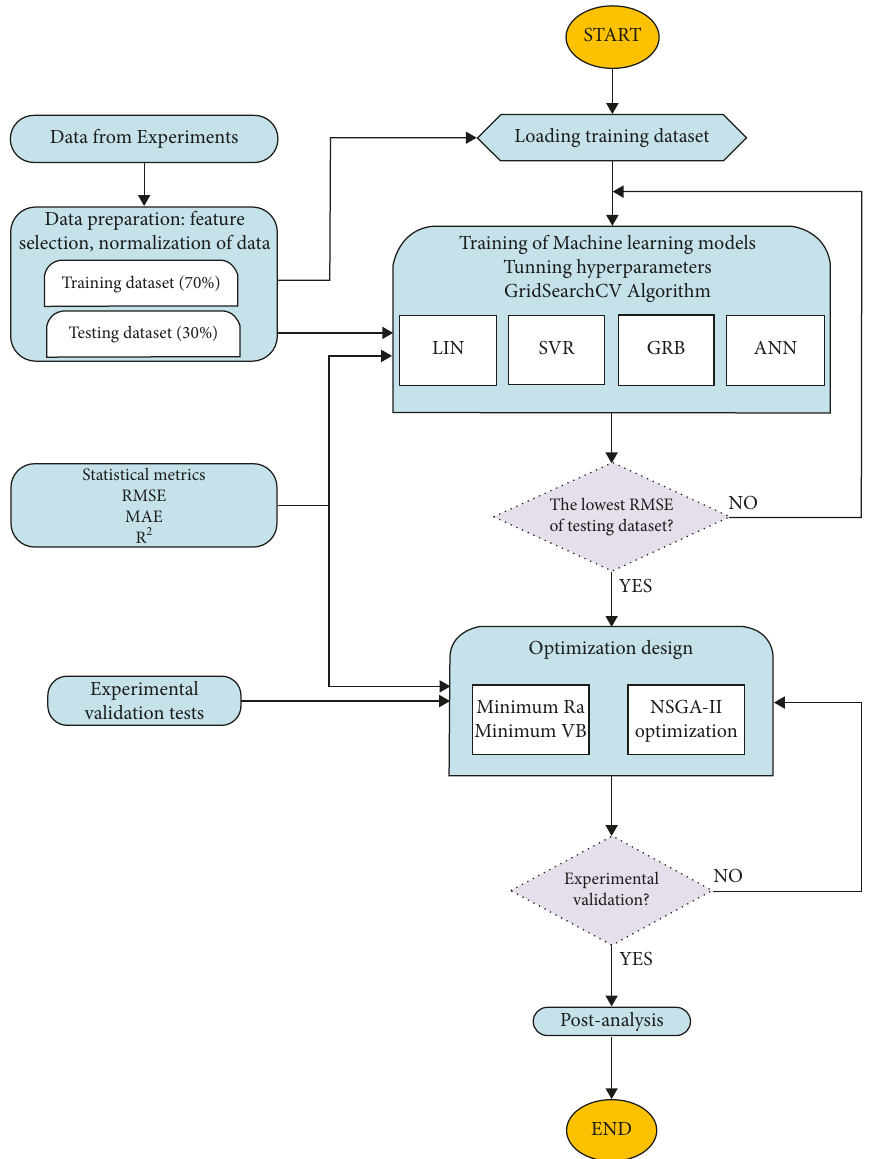
Figure 1: Flowchart of the study